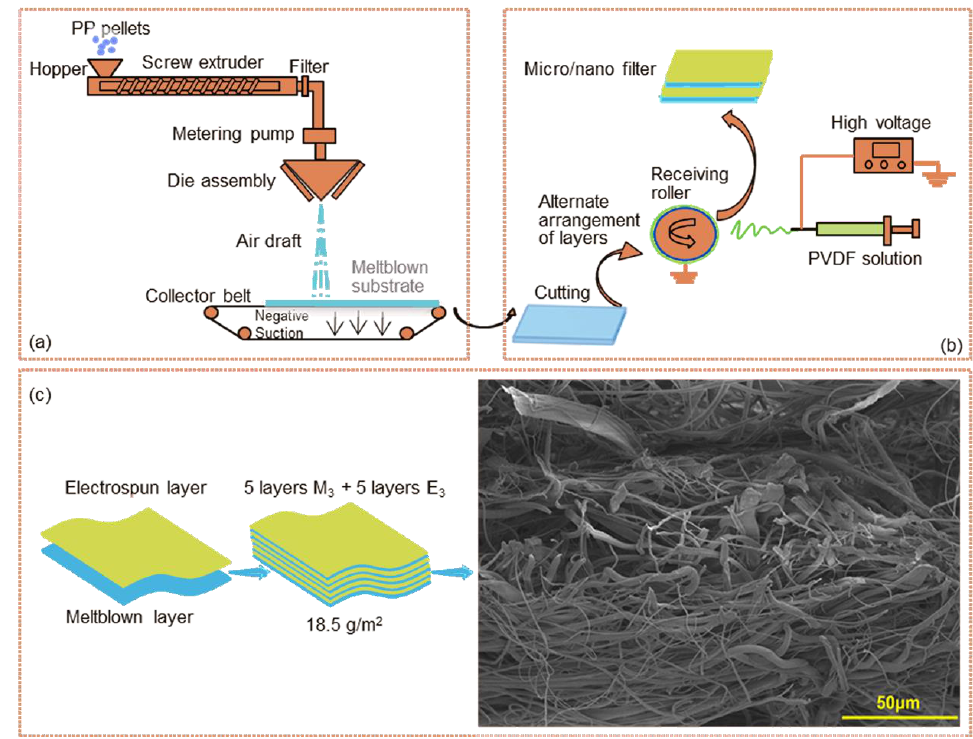
Figure 1. Fabrication of the composite filter ( a ) preparation of meltblown, ( b ) preparation of the laminated micro/nano filter, ( c ) structure diagram and cross-section SEM photography of M 3 E 3 *5.